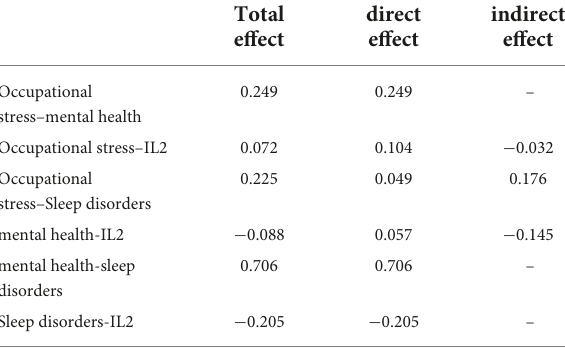
TABLE 8 Total effects–direct effects–indirect effects among